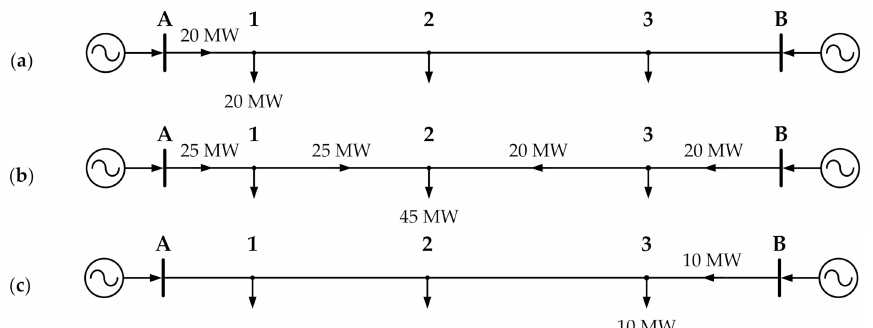
Figure 3. Decomposition of the base case power flow by the power flow tracing method–active power flows in the branches for the consumer in the bus: ( a ) 1; ( b ) 2; ( c )